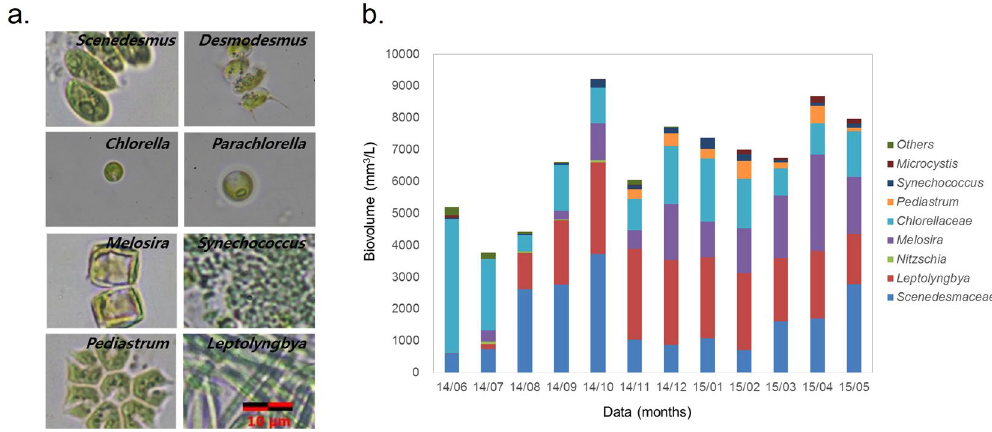
Figure 2. ( a ) Photomicrographs of dominant microalgal and cyanobacterial taxa found in HRAP. ( b ) Microalgal diversity in the HRAP based on biovolume calculations. Biovolume was calculated from cell numbers and volumetric data based on image